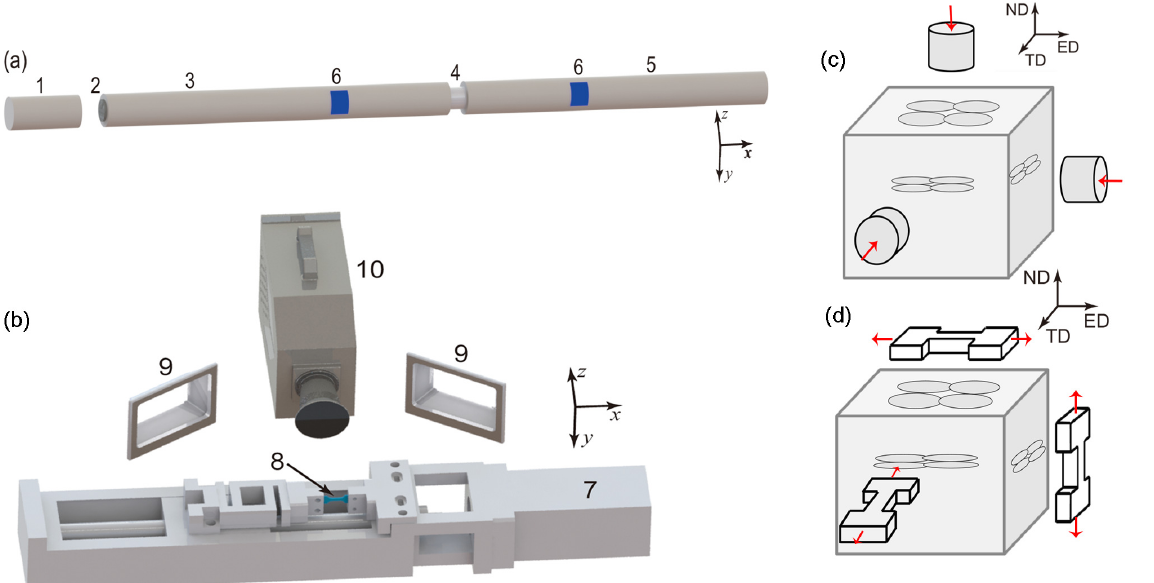
Figure 2. ( a ) Schematic diagram of a split Hopkinson pressure bar. ( b ) Schematic diagram of a material test system implemented with in situ optical imaging. ( c , d ) Illustration of the sample harvesting scheme and the loading axis (the red arrows) in the sample coordinate system (ED-TD- ND) for compression ( c ) and tensile ( d ) tests. 1: striker bar; 2: pulse shaper; 3: incident bar; 4: compression specimen; 5: transmission bar; 6: strain gages; 7: mini-MTS; 8: tension specimen; 9: light sources; 10: